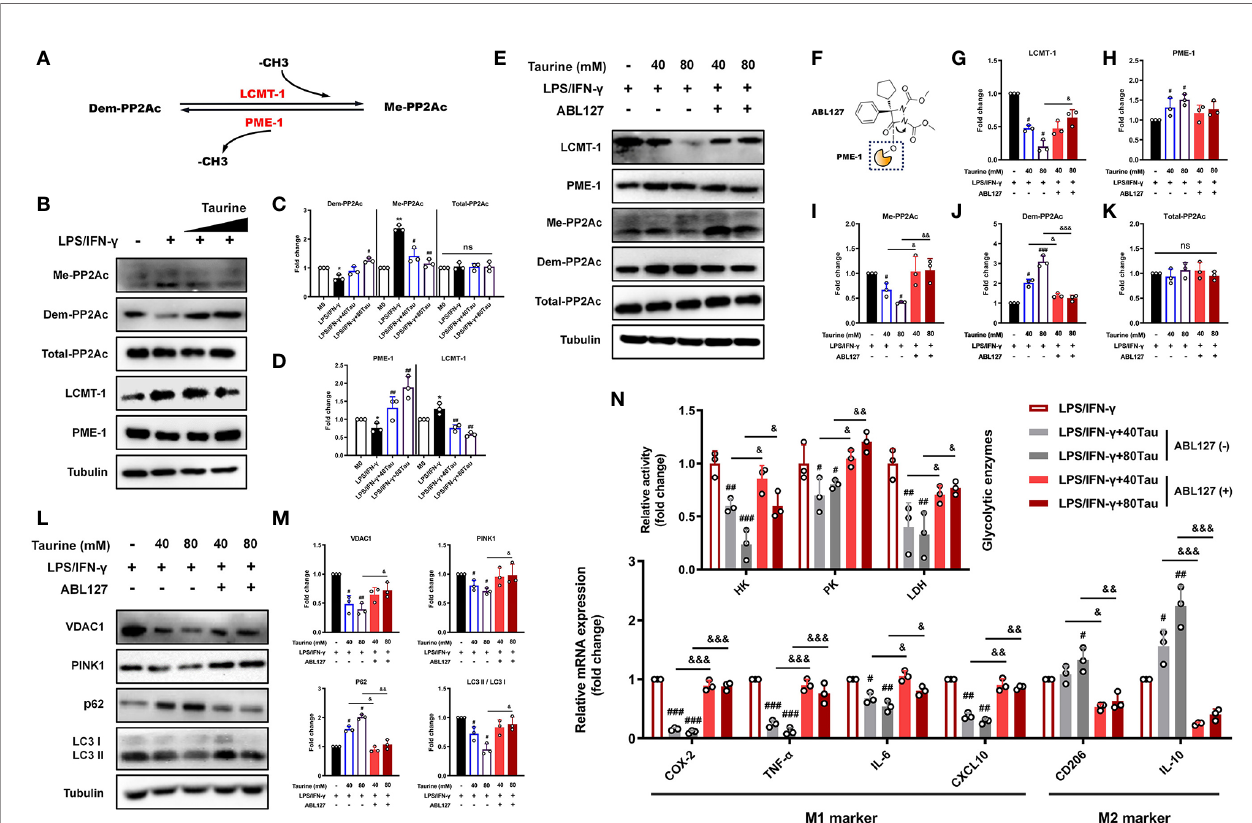
FIGURE 5 | ABL127 prevents the blocking of taurine on mitophagy/glycolysis in LPS/IFN- g -challenged macrophages. (A) Schematic of PP2Ac methylation reaction. (B) Taurine inhibits PP2Ac methylation for the representative immunoblots and (C, D) quantitation of methylated-PP2Ac, demethylated-PP2Ac, total-PP2Ac, LCMT- 1, and PME-1. (E) Representative immunoblots and (G – K) quantitation of total-PP2Ac, methylated-PP2Ac, demethylated-PP2Ac, LCMT-1, and PME-1 with ABL127 treatment. (F) Schematic representation of ABL127 structure. (L, M) Representative immunoblots of VDAC1, PINK1, p62, and LC3II/I and its quantitative analysis. (N) The glycolytic enzyme activity and the mRNA levels of M1 markers and M2 markers with ABL127 treatment. n=3. *p < 0.05 and **p < 0.01 vs. M0; #p < 0.05, ##p < 0.01 and ###p < 0.001 vs. LPS/IFN- g ; &p < 0.05, &&p < 0.01, &&&p < 0.001 vs. Taurine; ns, p >